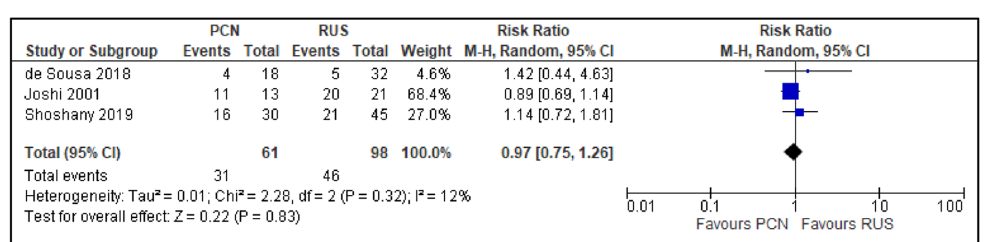
Figure 9. Comparison between PCN and RUS for outcome QoL – usual activity.